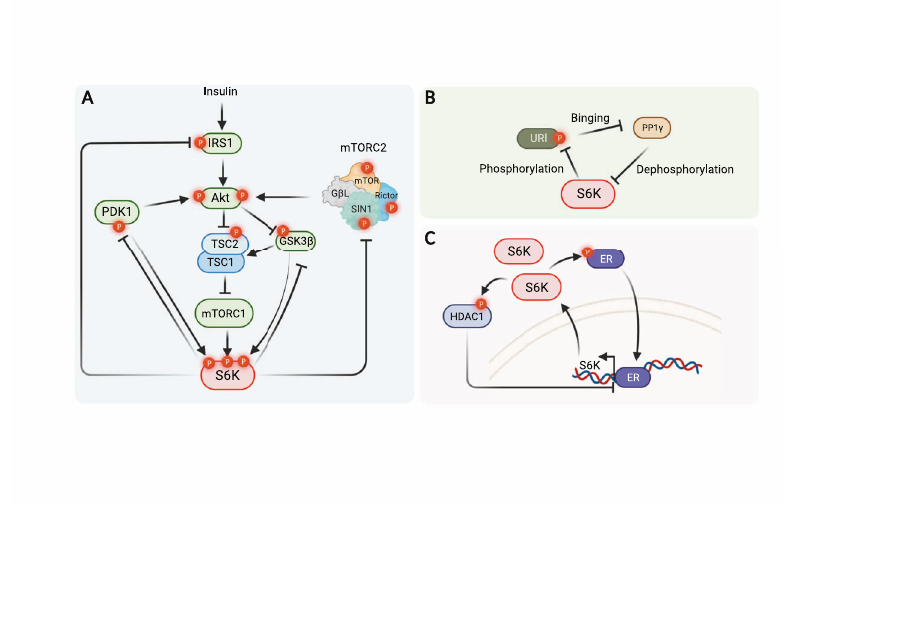
Fig. 5 S6K functions in feedback regulation. A Feedback regulation of the PI3K-AKT signaling pathway. S6K could phosphorylate multiple sites of IRS1, leading to its degradation and insensitivity to insulin treatment. S6Ks also tune the activity, stability, or complex formation of PDK1 and mTORC2, key regulators of full AKT activation. Inhibition of AKT in turn will fail to release mTORC1 activity, resulting in subsequent suppression of S6Ks. B S6K1 is able to phosphorylate URI, leading to disassociation of the URI/PP1 γ complex, which liberates the phosphatase activity of PP1 γ that functions to inactivate S6K1. C ER α could bind to the promoter of S6K and promote its transcription; on the other hand, ER α is subject to phosphorylation by S6K1, which promotes the transcriptional activity of ER α . Phosphorylation and activation of